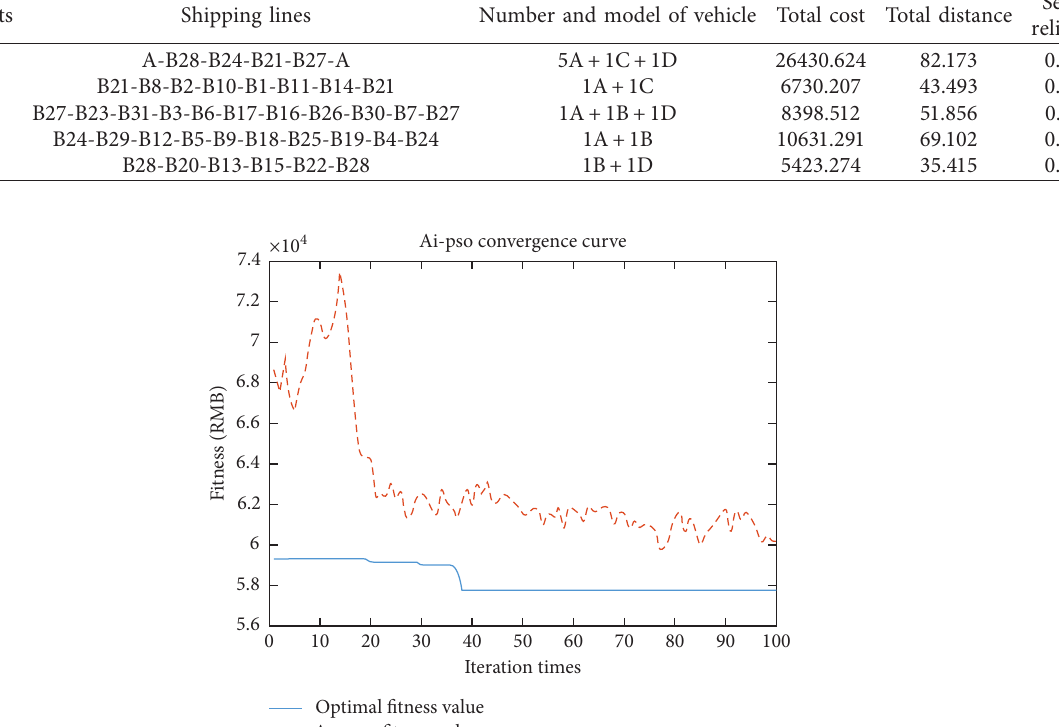
Table 7: Cold chain transport path, distance, cost, and service reliability in a static environment. Service